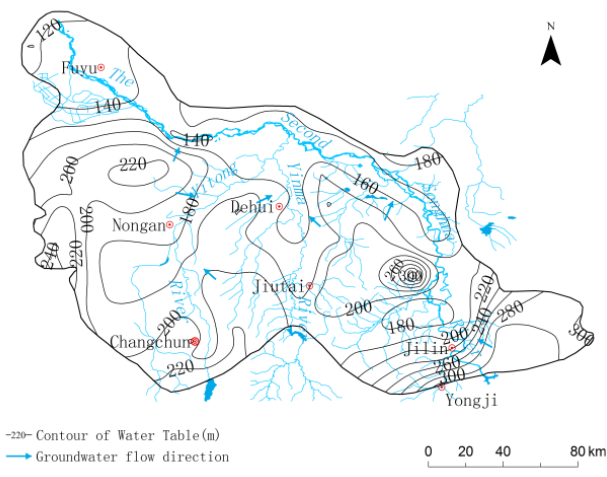
Figure 4. Contour of the water table.